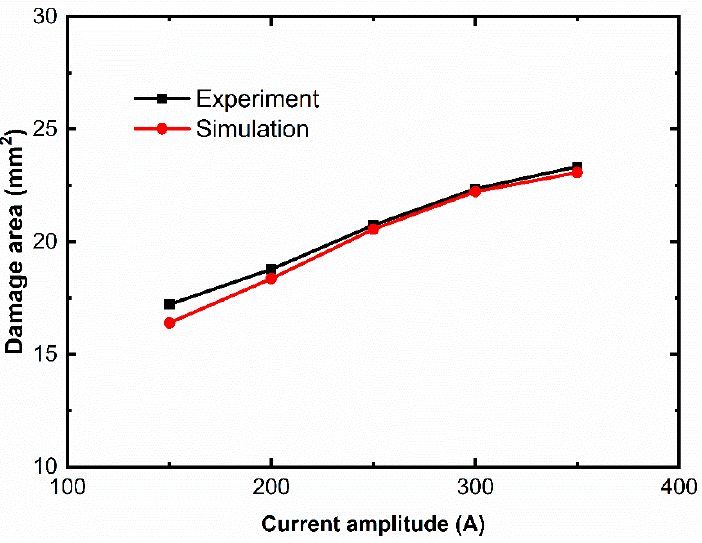
Figure 22. Lightning striking damage aera versus current amplitude curves.